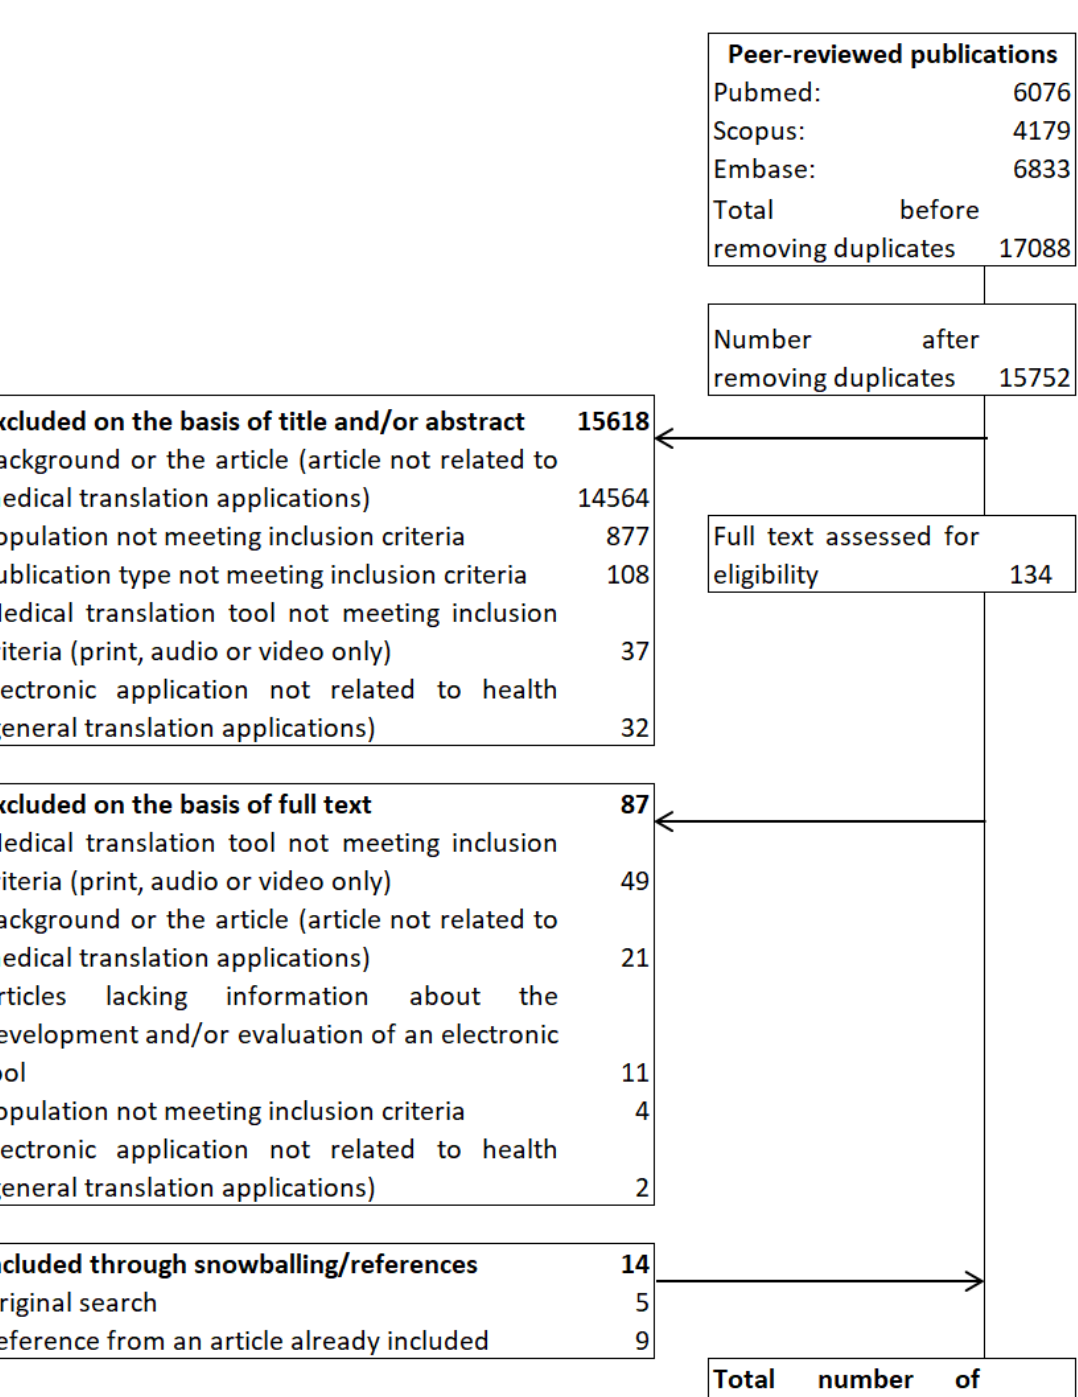
Figure 1. Flowchart of article